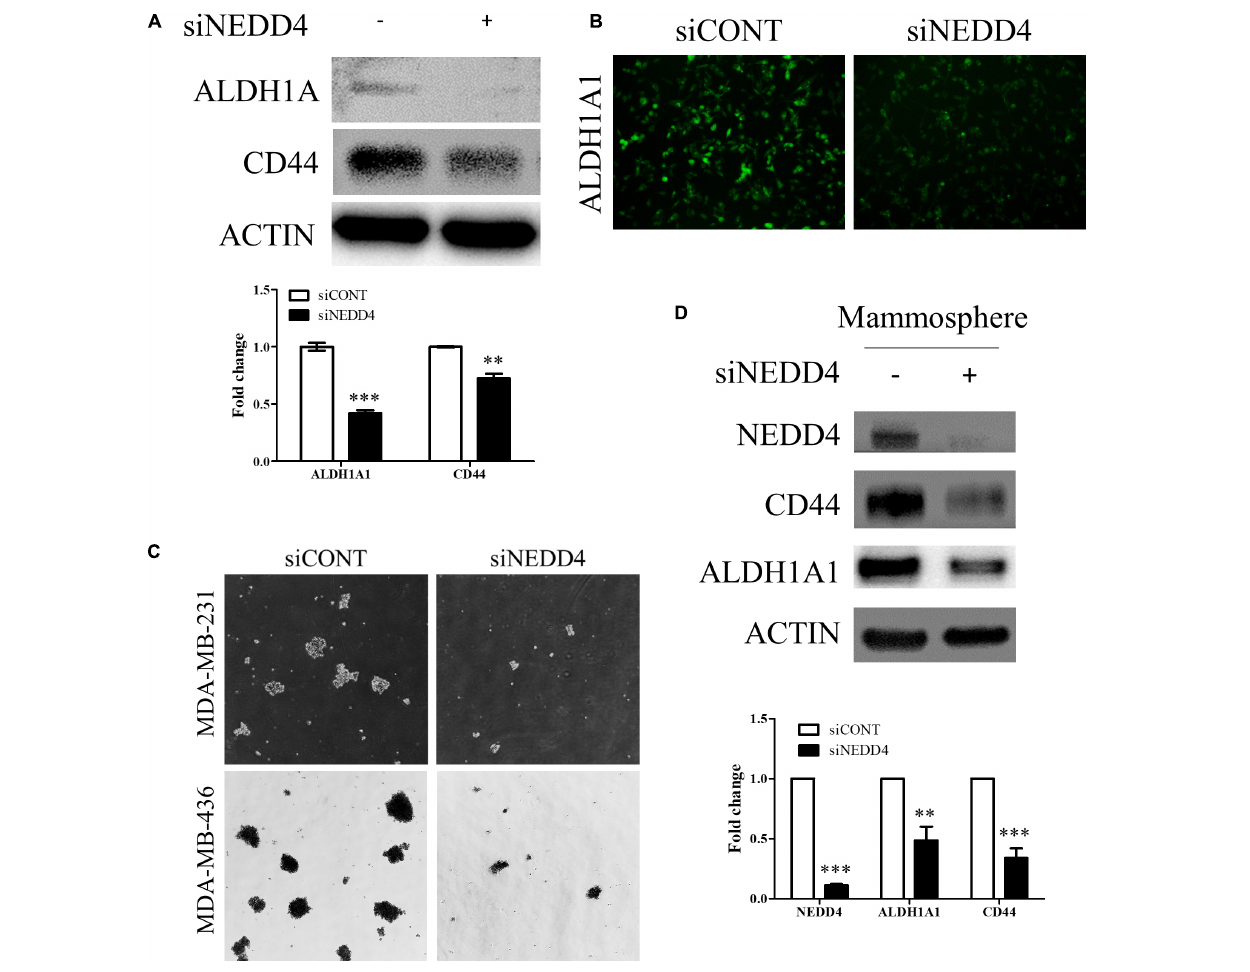
FIGURE 5 | The expression and the activity of breast cancer stem cell (BCSC) markers were decreased in NEDD4-deleted MDA-MB-231. (A) The expression of BCSC markers including ALDH1A1 and CD44 was confirmed by western blot in siCONT- and siNEDD4-treated MDA-MB-231. β -actin was used as a loading control. (B) The activity of ALDH1A1 was confirmed by the ALDEFLUOR kit system in siCONT/NEDD4-treated MDA-MB-231 cells. The representative images are shown. The average value is shown in the graph ( n = 3). (C) siCONT/NEDD4-treated MDA-MB-231 cells were induced to mammosphere formation for 2 weeks. The representative images are shown ( n = 3). (D) The lysates harvested from the mammosphere formation were subjected to western blot using the indicated antibodies. β -actin was used as a loading control. The representative images are shown. The average value is shown in the graph ( n = 3) (** P < 0.01 and *** P < 0.001).